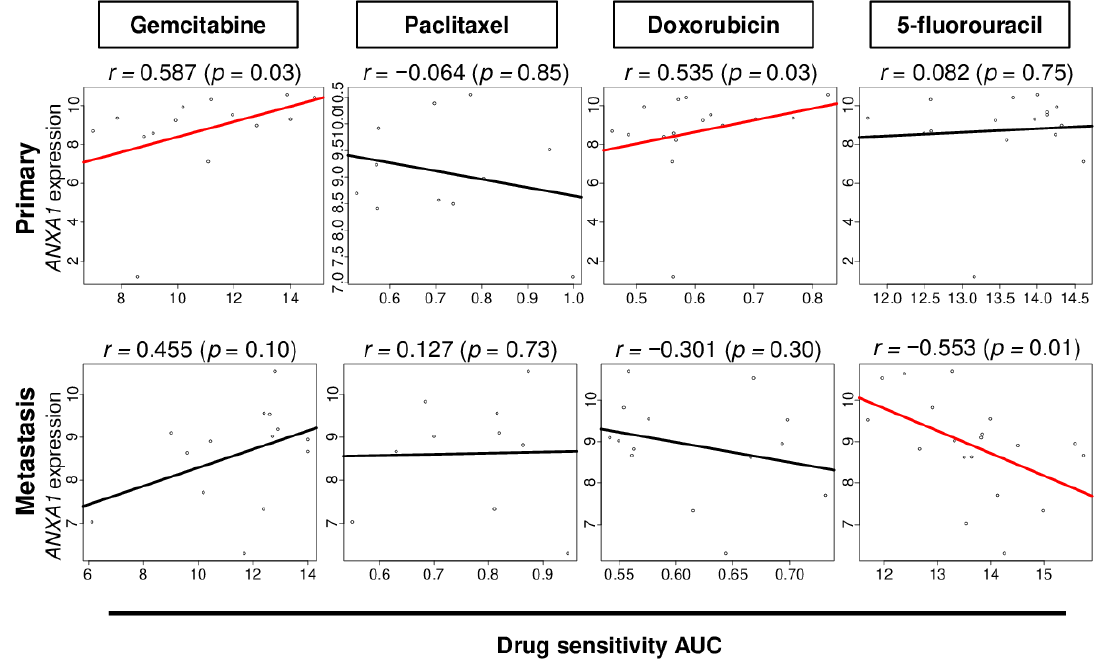
Figure 7. Correlation of the ANXA1 expression with the drug sensitivity of several drugs in primary and metastasis PC cell lines. The correlation plots of the ANXA1 expression with the level of drug sensitivity area under the curve (AUC) of gemcitabine, paclitaxel, doxorubicin, and 5-fluorouracil. Spearman’s rank correlation coefficient was used for the analysis.